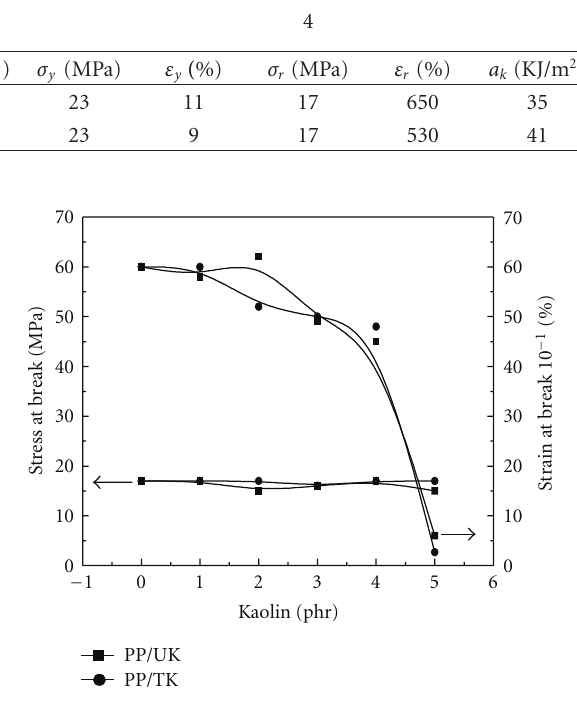
Figure 4: PP composites yielding stress and strain variations as a function of treated and untreated kaolin concentration.